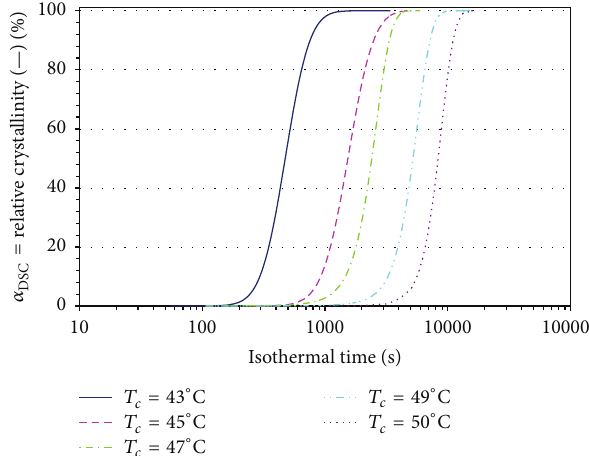
Figure 3: Evolution of relative crystallinity ( 𝛼 in isothermal